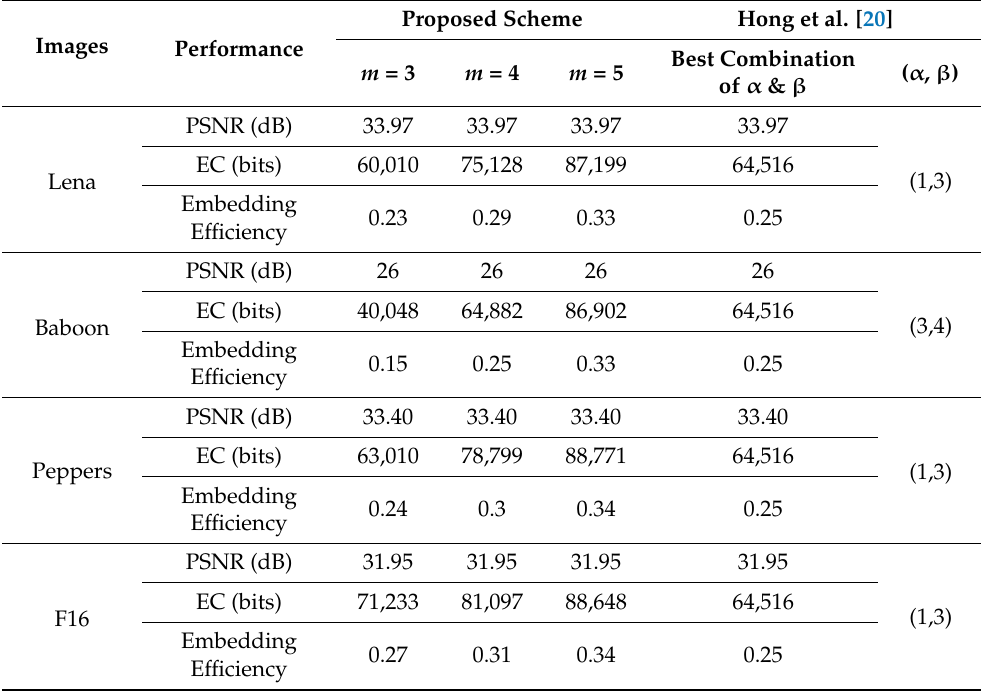
Table 3. Performance comparison of the proposed scheme and Hong et al.’s scheme [20] on PSNR, EC, and embedding